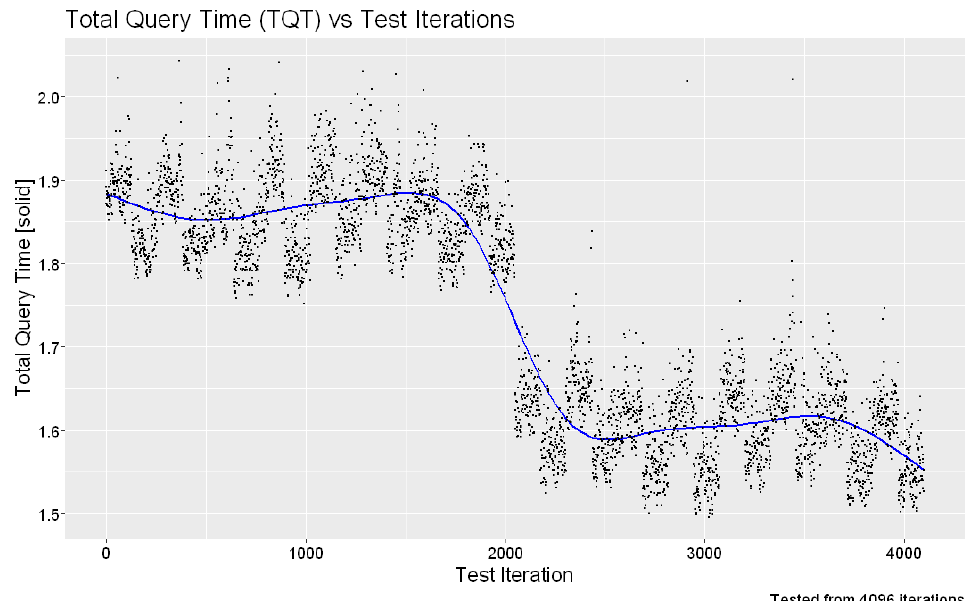
Figure 7. SQL Query Time vs. Run Iteration.